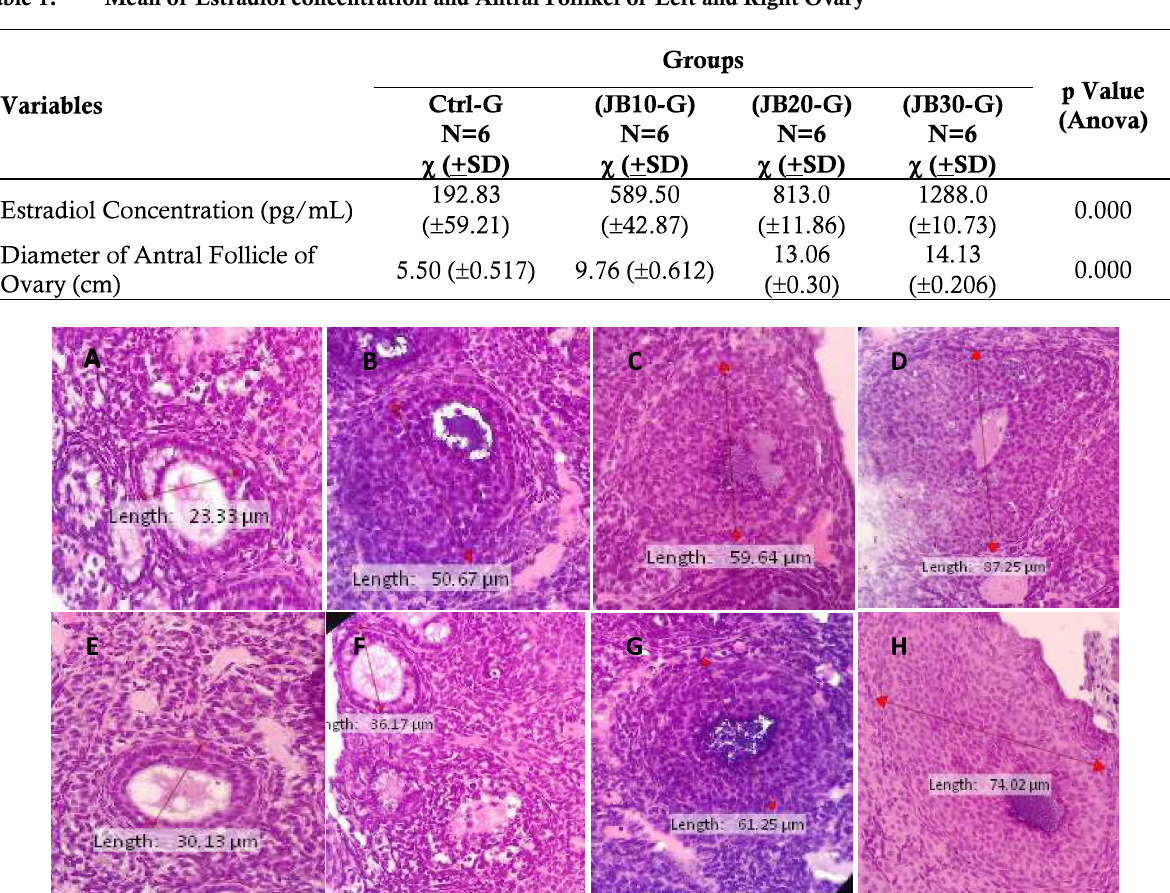
Figure 1. Diameter of Antral Follicle Left and Right Ovary were statained hy